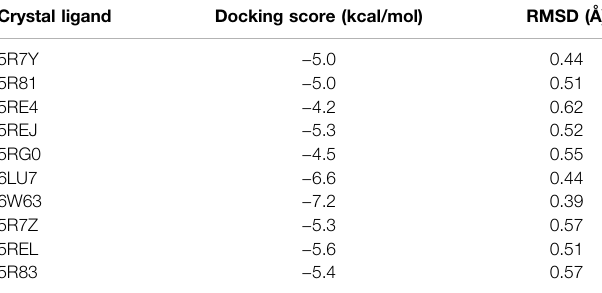
TABLE 2 | RMSD errors for redocking small molecule ligands into the binding site of M pro . Crystal